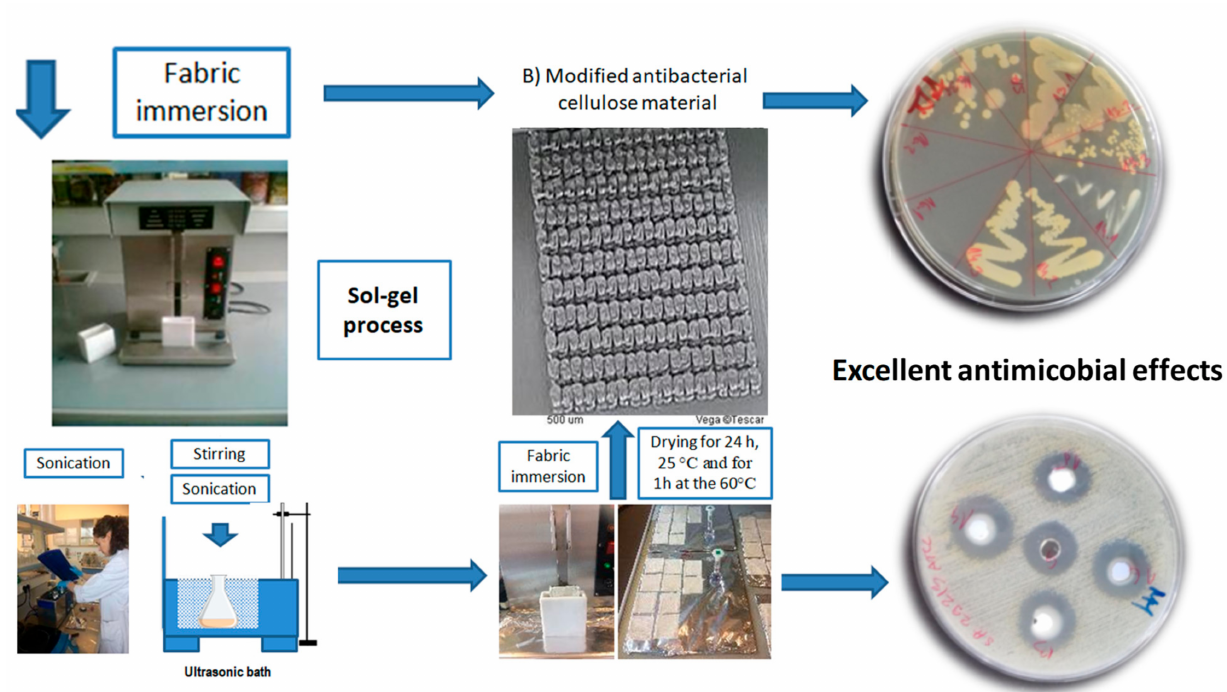
Figure 1. Schematic overview of different steps in preparation of the antimicrobially functionalized biodegradable polymers by sol–gel process and the resulting antimicrobial efficiency. Table 1. Results of antimicrobial investigation of metal and metalo oxide nanoparticles on